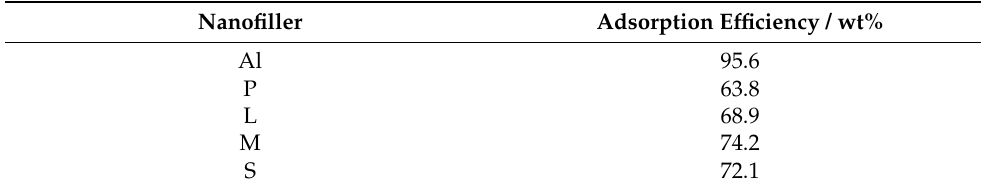
Table 3. Adsorption efficiency for nanofiller concentrations of ca. 10 wt %.